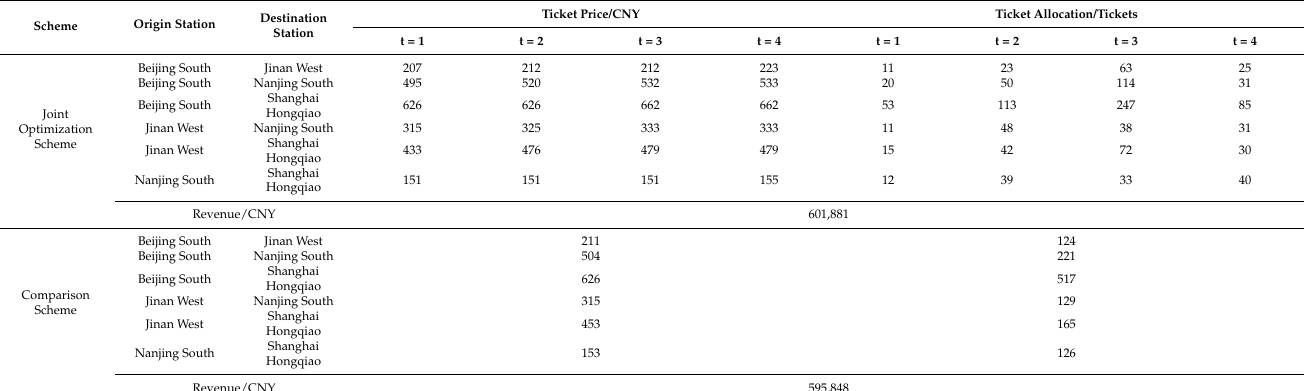
Table 9. Comparison table of model